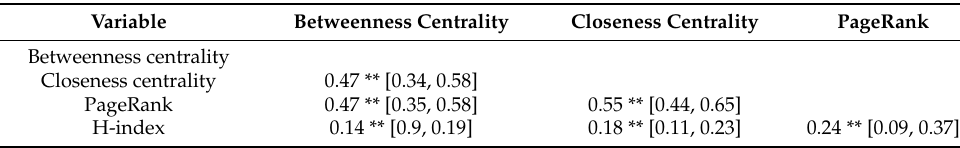
Table 15. Correlation analysis with network measures. Variable Betweenness Centrality Closeness Centrality PageRank Betweenness centrality Closeness